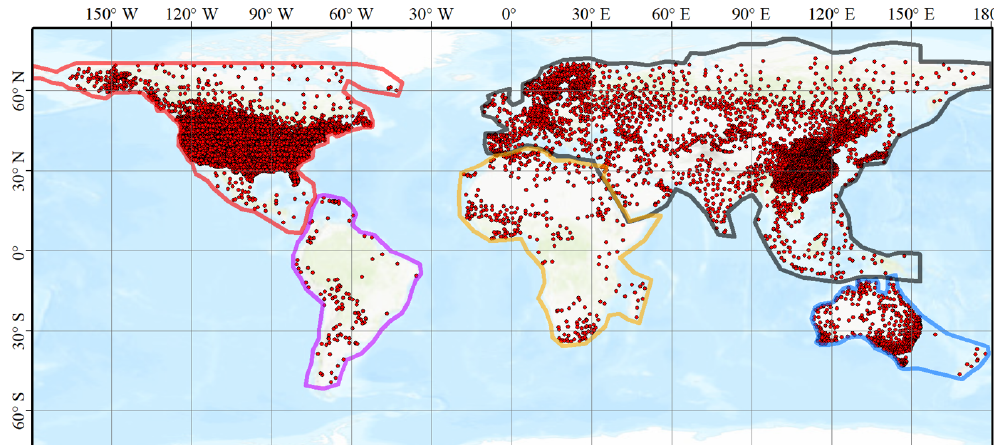
Figure 1. Regions and locations of weather stations in this study. Red points are the locations of weather stations, and polygons are the boundaries of regions used in the SVCM-SP algorithm. Specifically, polygons of red, purple, orange, blue, and black represent the boundaries of North America, South America, Africa, Australia, and Europe and Asia, respectively.